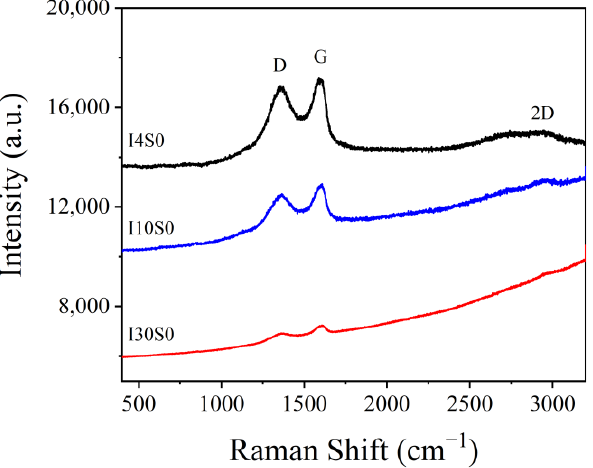
Figure 12. Raman spectra of specimens recycled from tap water electrolyte.